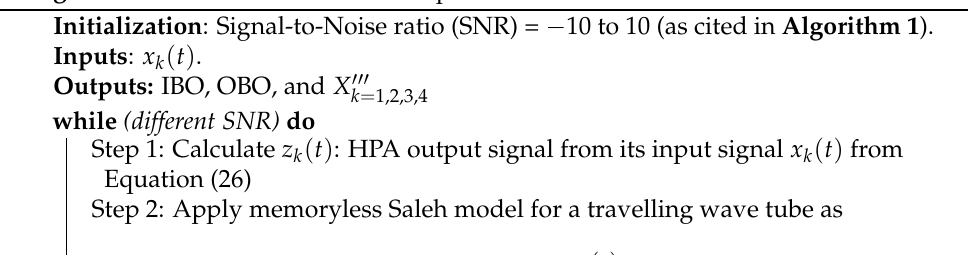
Algorithm 2: For user k with HPA